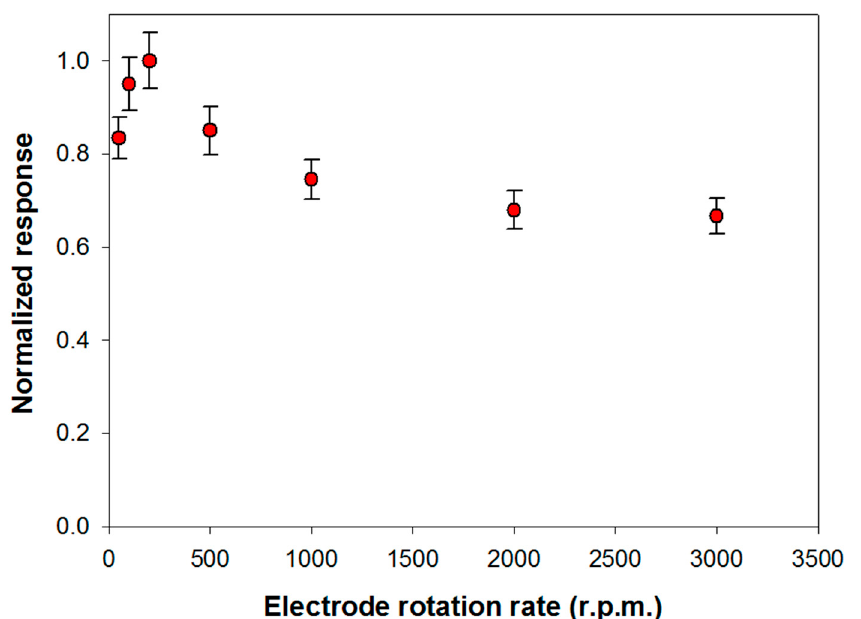
Figure 3. Normalized response (i.e., response/maximum response) of a typical Pt/PPyox/ChO biosensor to PLD 0.22 IU/mL as a function of electrode rotation rate. Supporting electrolyte: Tris buffer pH 8.0, I 0.05 M containing 0.75% (v/v) Triton X-100, 0.2 mM calcium chloride, and 5 mM phosphatidylcholine. Each value represents the mean of triplicate measurements; the error bars represent the relevant standard deviations.